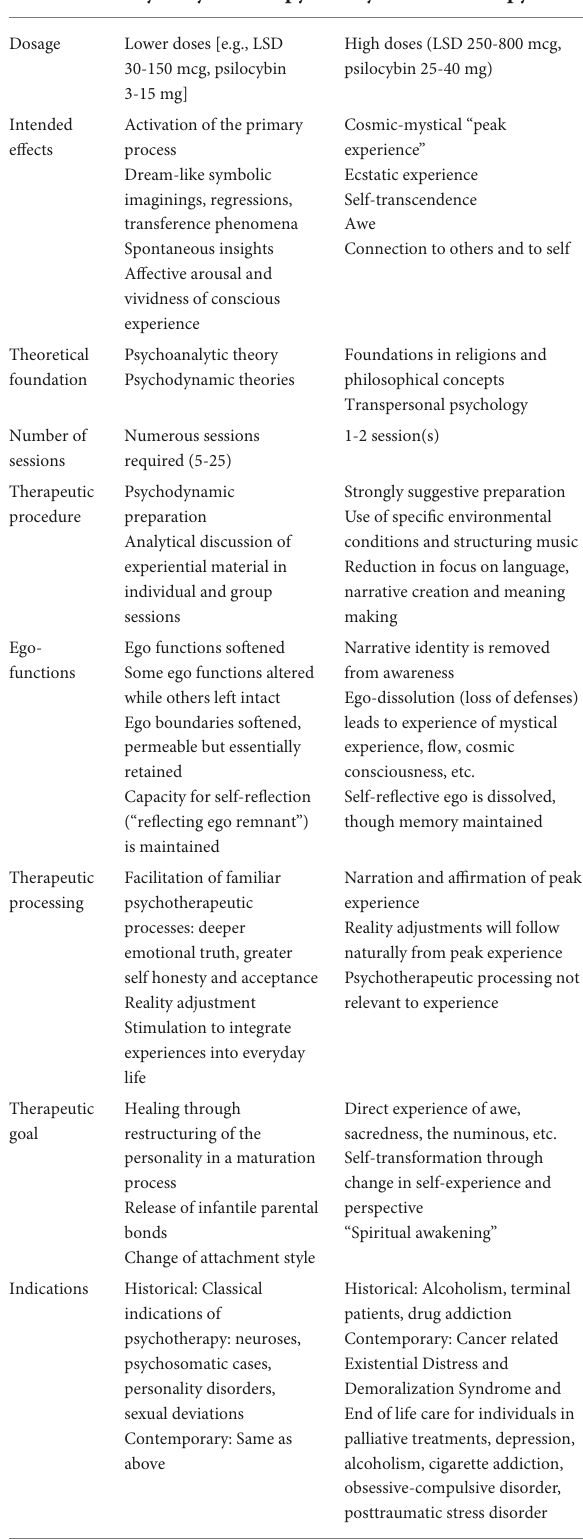
TABLE 1 Comparison of the two main methods of using hallucinogens in psychotherapy [cf. (4,